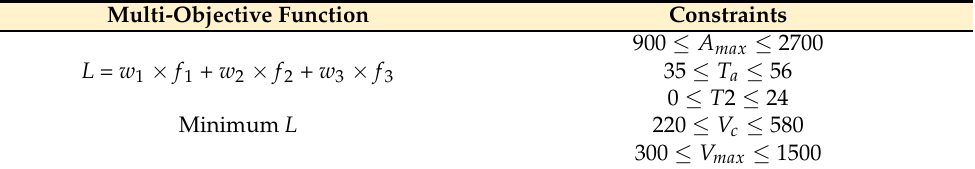
Table 4. Multi-objective function and constraints following the weighted sum approach.